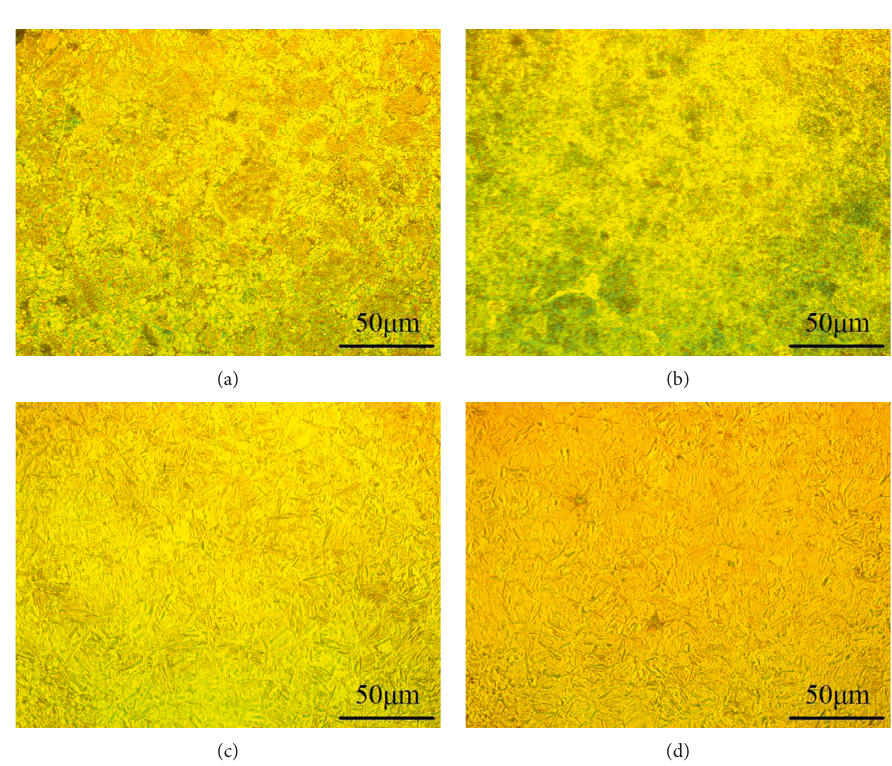
Figure 3: The metallographs of 34CrNiMo6 steel with different ratios of Al to N. (a) No Al element added. (b) The ratio of Al to N is 2.2. (c) The ratio of Al to N is 2.8. (d) The ratio of Al to N is